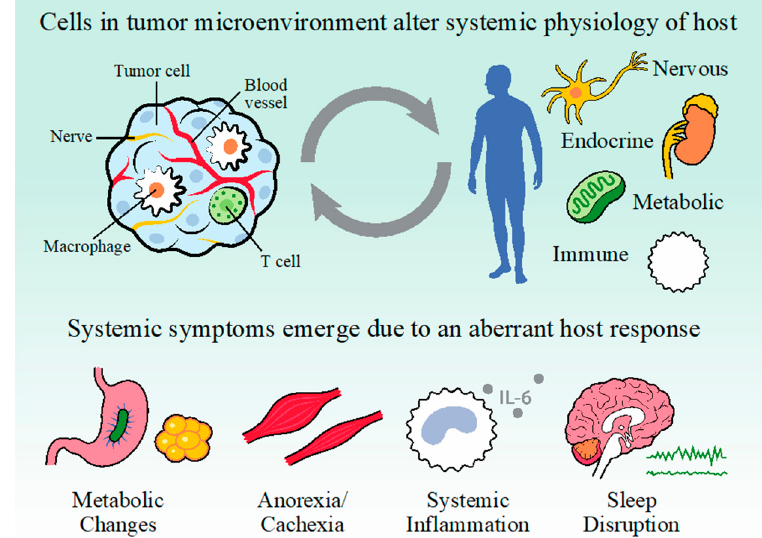
Figure 1. Cancer in the periphery dynamically interacts with nervous, endocrine, metabolic, and immune systems (NEMI) to elicit systemic changes in physiology and behavior. Tumor cells and those comprising its microenvironment secrete cytokines, growth factors, chemokines, and metabolites that the brain is sensitive to. This homeostatic challenge promotes aberrant neural activity, which then contributes to devastating symptoms like sleep disruption, inflammation, anorexia / cachexia, and changes in metabolism.